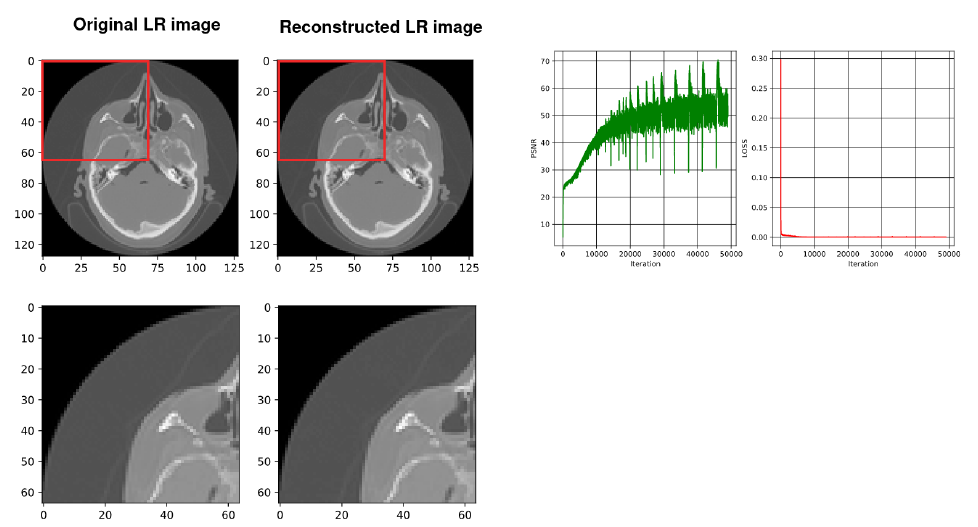
Figure 6. From the left, the first image shows the original down-sampled image. The second image illustrates the reconstructed counterpart of the down-sampled image using a four-layer SIREN. The next image shows the plot of the PSNR during training of the network (best PSNR: 70.63) and the last image shows the plot of the loss values during the four-layer SIREN training (loss: 8.6481705 × 10 − 8 ).